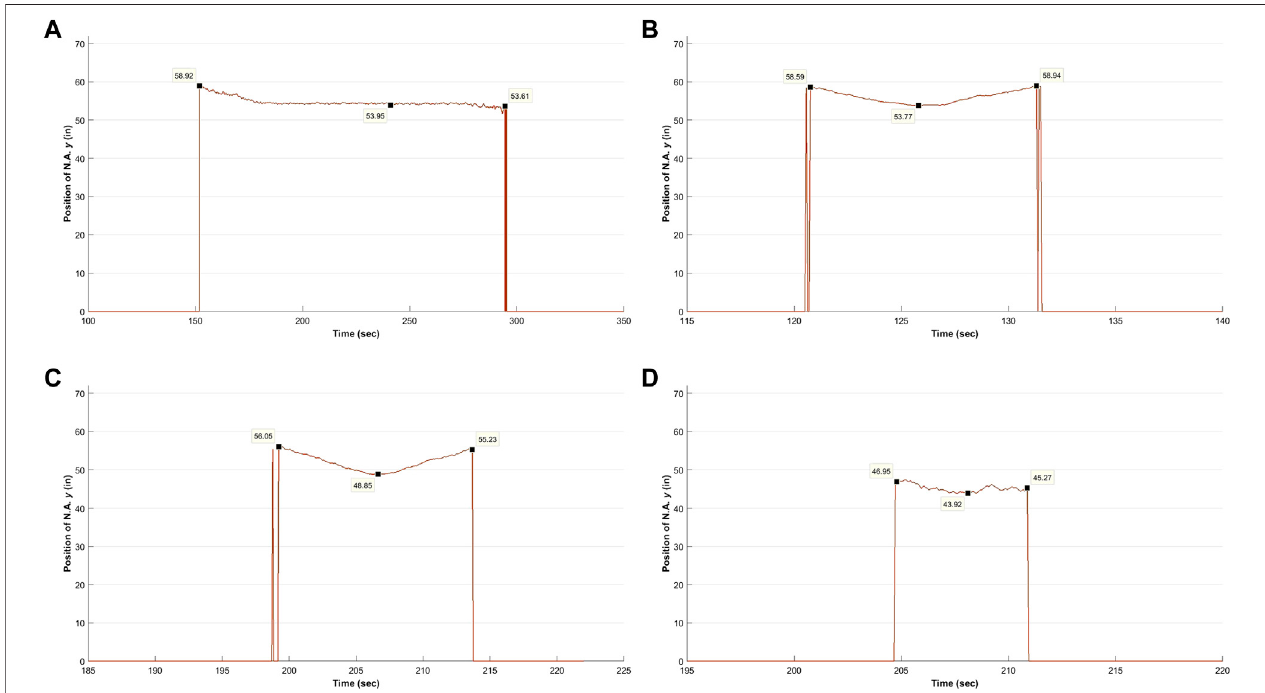
FIGURE 4 | Time histories of N.A. position y (as measured from the bottom of the girder) in the west girder during load test 6 (A) at midspan (MS) under the static load of six trucks, (B) at midspan (MS) during the six-truck pass, (C) at controlling location (CL) during the six truck pass, and (D) at controlling location (CL) during the single-truck pass. N.A. is only printed for times that both top and bottom sensor exceeded 10 με .